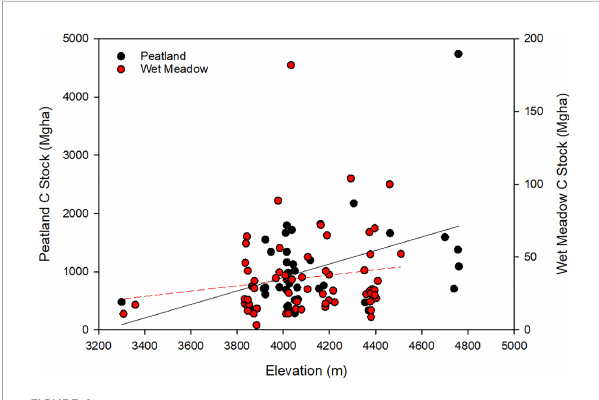
FIGURE 4 Correlation between peatland carbon stocks (Black circles: Peatland C-Stock=1.16(elevation)-3736.3, R2 = 0.19, P<0.004) and wet meadows (Red circles: Wet meadow C-Stock=0.018(elevation)-39.3, R2 = 0.02, P<0.22) and elevation. Note the difference in scale between the peat samples (left y axis) and the wet meadow samples (right y axis).